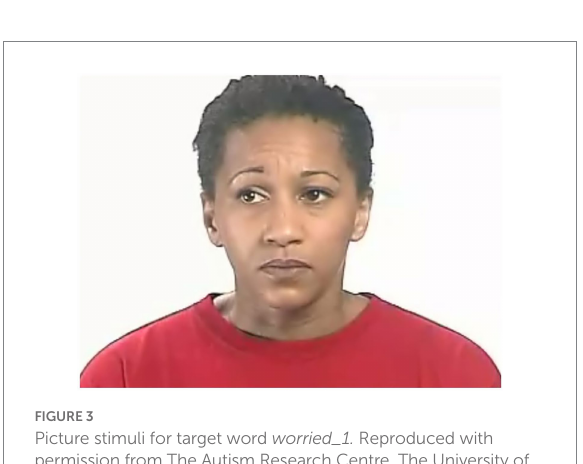
FIGURE 3 Picture stimuli for target word worried_1. Reproduced with permission from The Autism Research Centre, The University of Cambridge; see footnote 1.